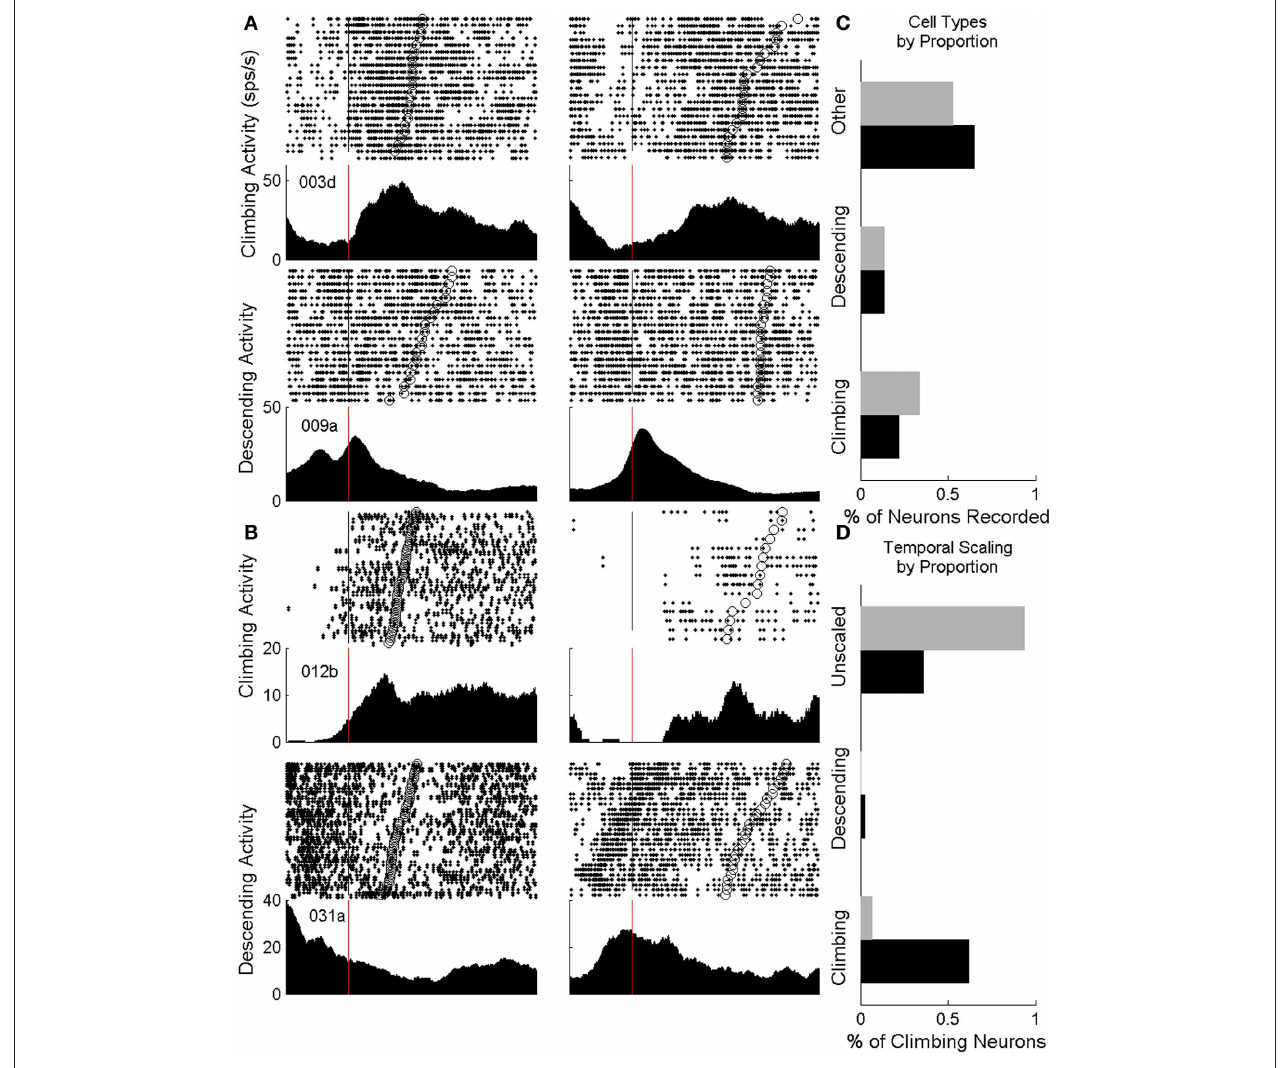
FIGURE 4 | Neurons from both groups displaying climbing activity. (A) Climbing and descending cells for IT animals. The perievent response peaks (troughs) at the end of press (open circles, rasters) while the overall change in firing rate stays the same between press durations (left: short, right: long duration). Vertical lines denote the start of press. (B) Identified climbing and descending cells for nIT animals display similar patterns of